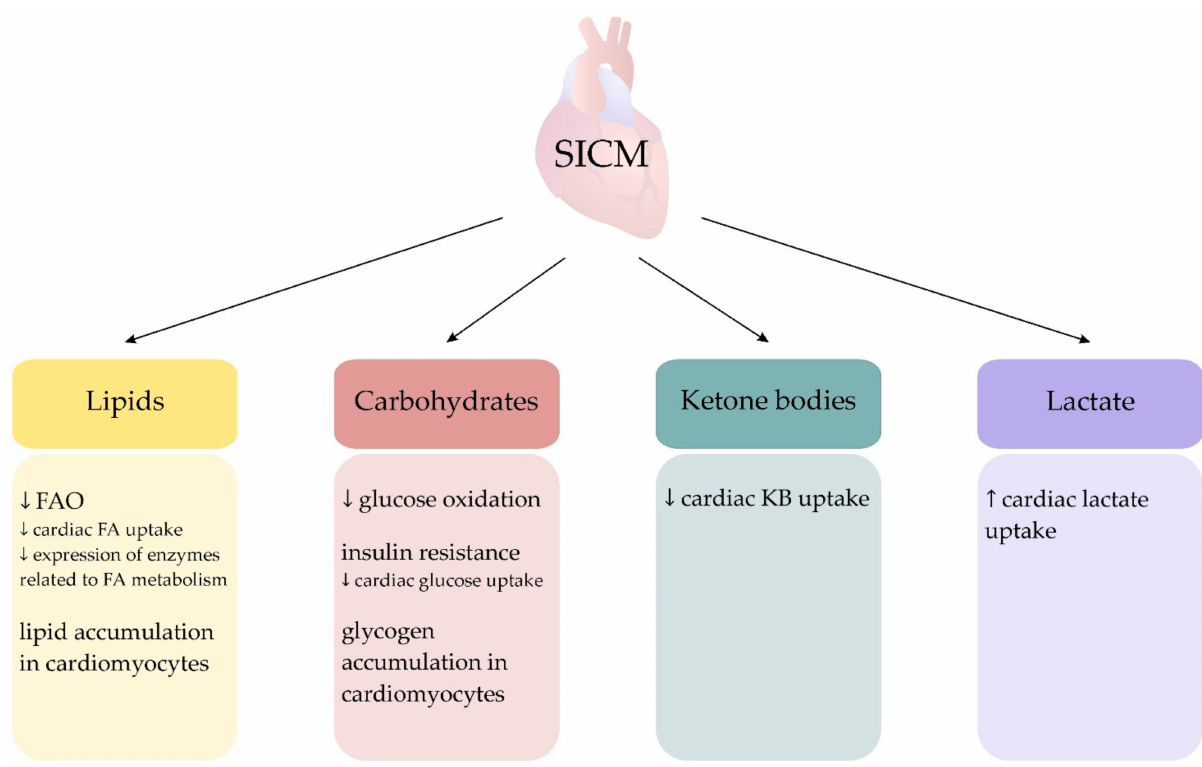
Figure 3. Changes in cardiac substrate metabolism in sepsis. Abbreviations: FA = fatty acids, FAO = fatty acid oxidation, KB = ketone bodies, ↓ = decrease, ↑ =